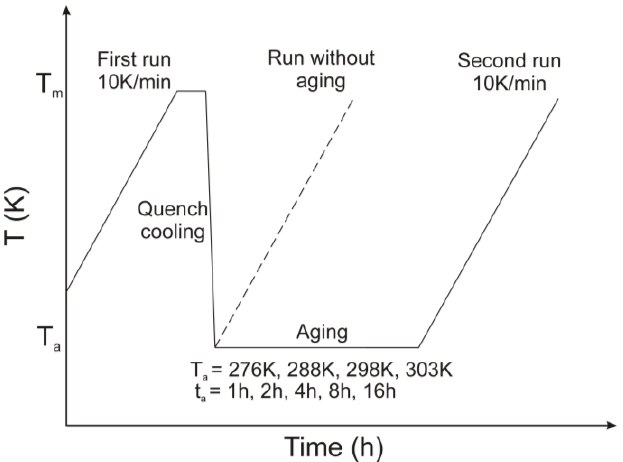
Figure 2. Temperature programme applied in differential scanning calorimetry (DSC) during the ageing experiments.